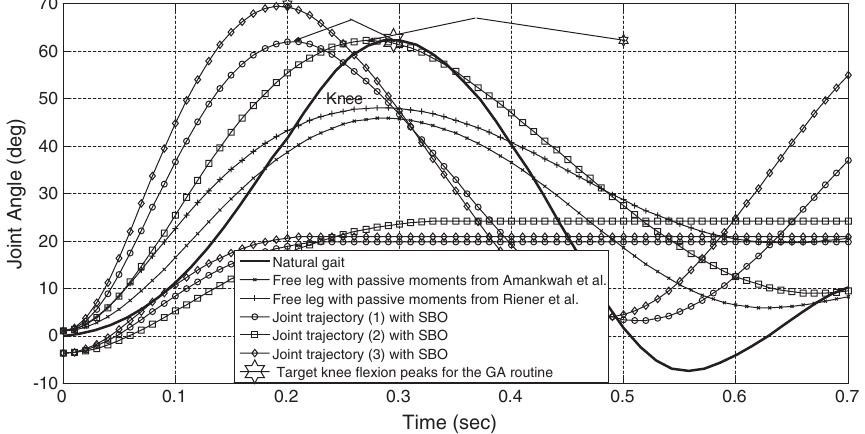
Fig. 6. Knee and hip joint trajectories 1, 2 and 3 with spring parameters optimized for the knee flexion peaks to appear at (0.31sec, 62.2 ◦ , (0.5sec, 62.2 ◦ and (0.2sec, 70 ◦ respectively. The arrowed lines indicate the distances of the actual knee flexion peaks from the target points as used in the GA routine.